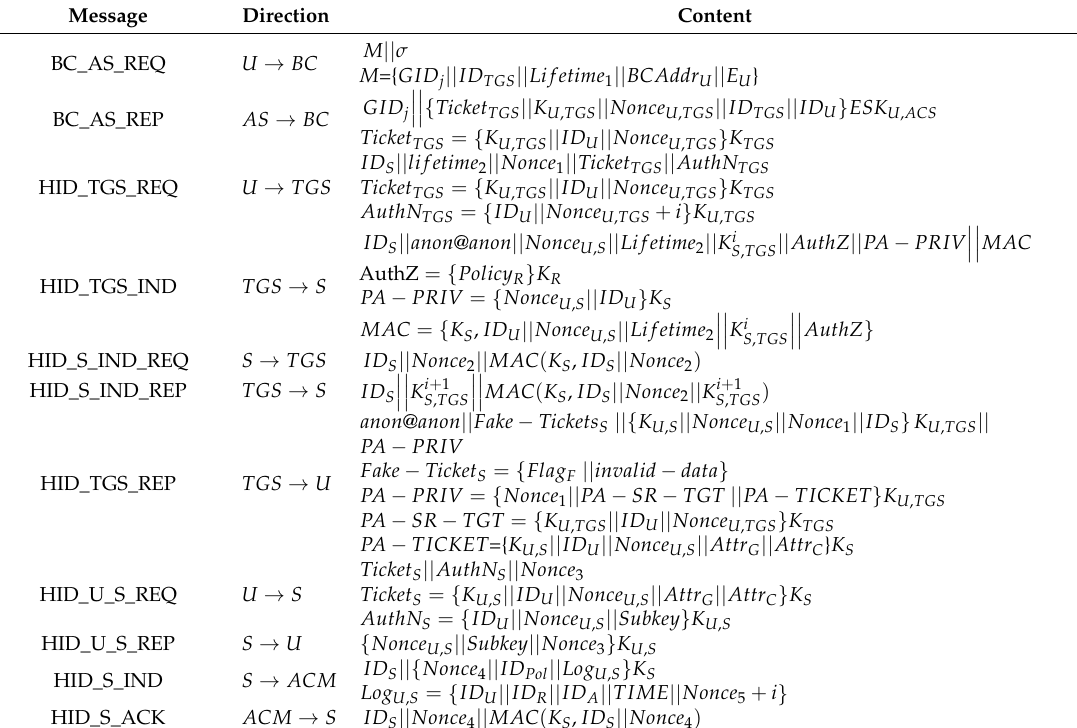
Table 4. Details of the content of enhanced Hidra